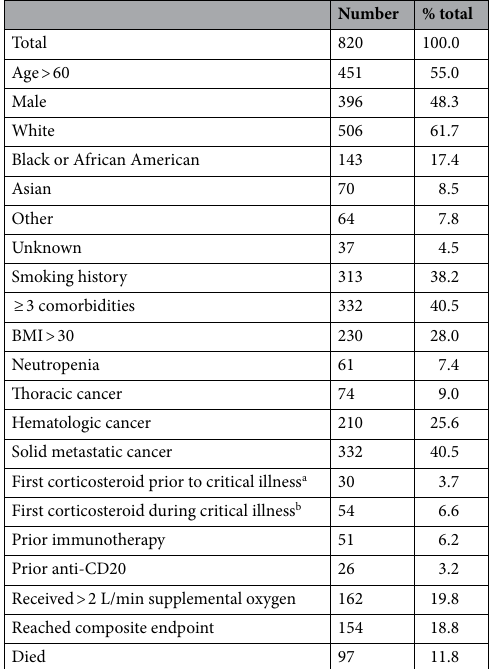
Table 1. Patient characteristics (not mutually exclusive). a High-flow oxygen, ventilation, or death. b During high-flow oxygen or ventilation and prior to